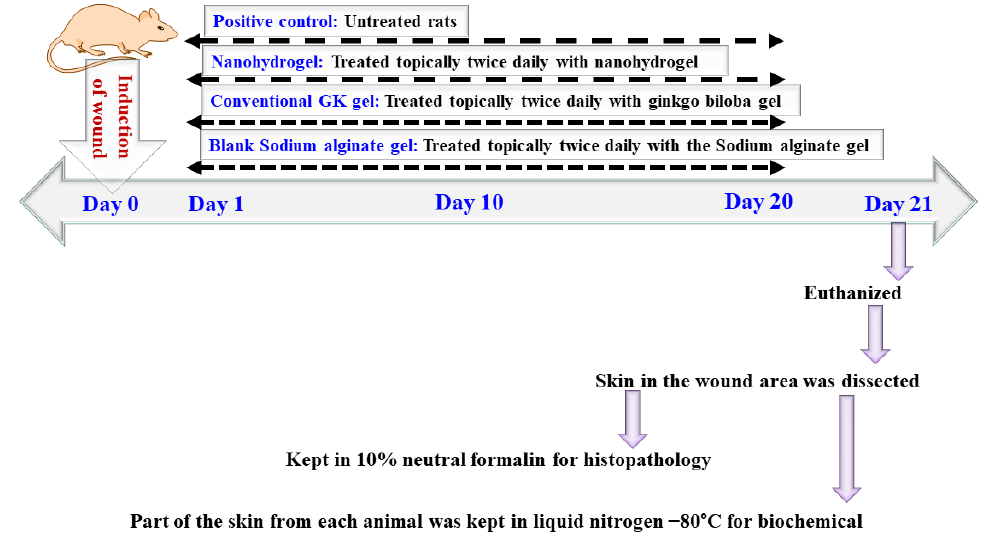
Figure 10. Treatment protocol used in the in vivo study.